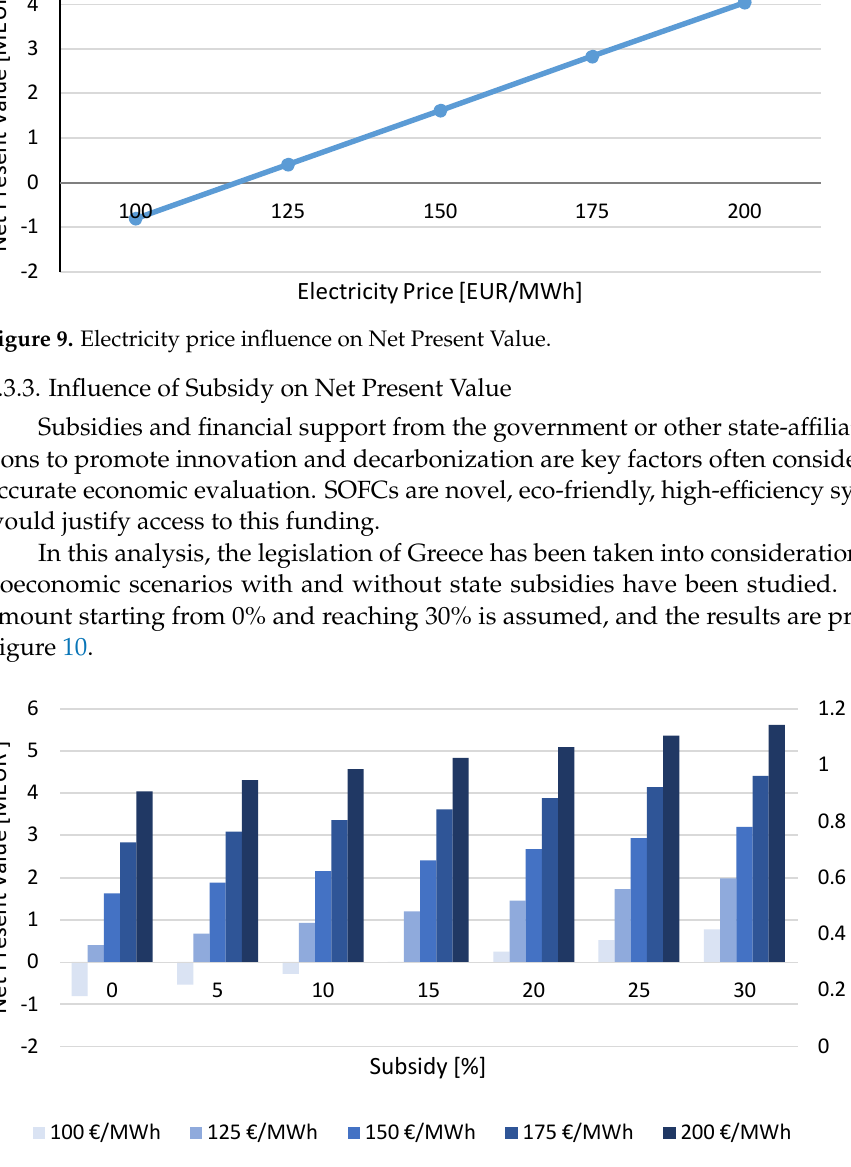
Figure 10. Subsidy effect on Net Present Value and electricity price.